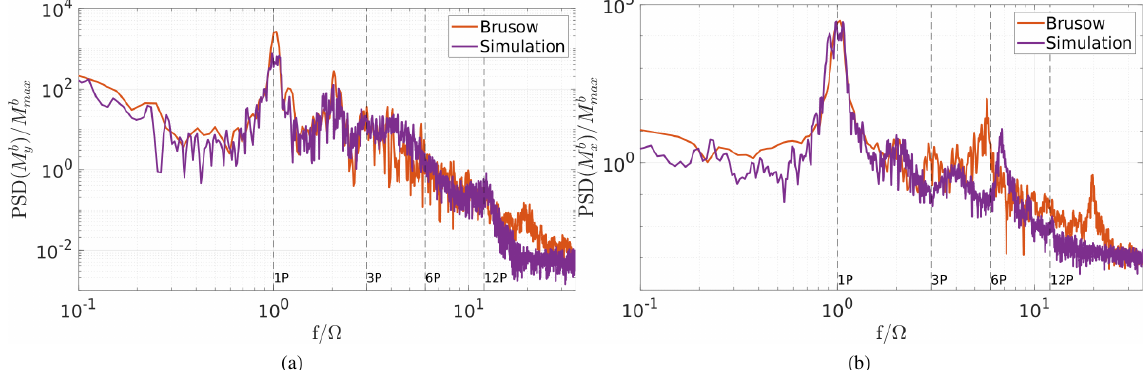
Figure B1. Spectrum of the blade root bending moment (a) out of plane M b y and (b) in plane M b x in comparison to the simulation results (neutral). The data are normalised by the maximum value of the blade root bending moments, and the frequency is normalised by the rotor speed.